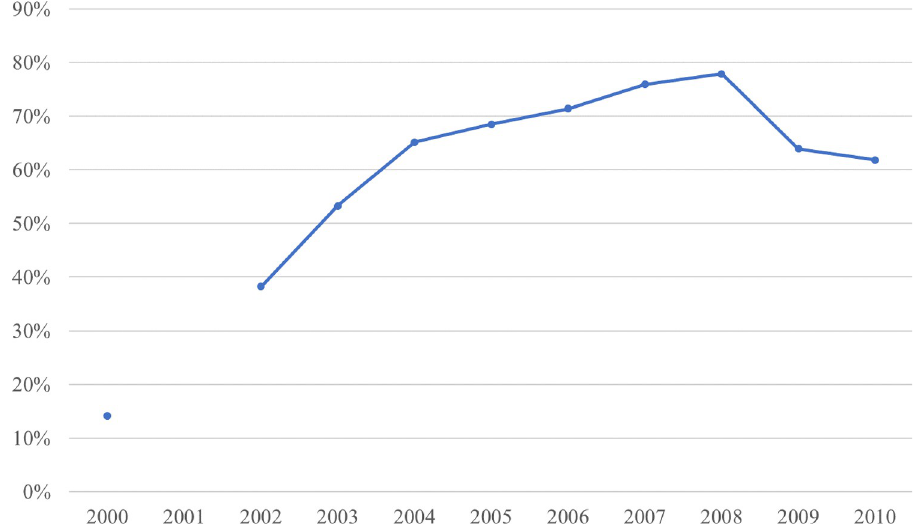
Fig 3. Market share of ultra-high-temperature processing milk 2000, 2002–2010. Note: Data source: China Dairy Yearbook. The market share data of other years has not been revealed by the yearbook.